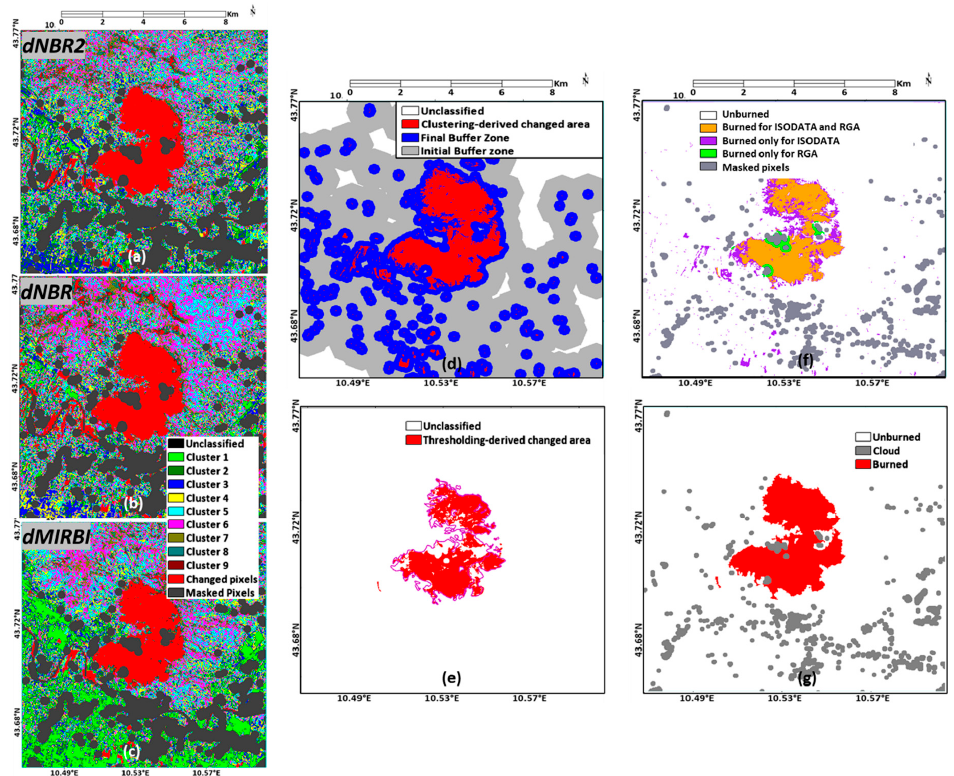
Figure 3. Full example of the results of the BFCA for the EMSR316 test case. Upper left panel ( a ): output of the ISODATA applied to dNBR2 . Central left panel ( b ): output of the ISODATA applied to dNBR . Lower left panel ( c ): output of the ISODATA applied to dMIRBI . Upper central panel ( d ): clustering-derived changed area and buffer zone. Lower central panel ( e ): thresholding-derived changed area. Upper right panel ( f ): pixels belonging to both clustering-derived and thresholding-derived BAs (orange), only to the clustering-derived BA (purple), only to the thresholding-derived BA (green). Lower right panel ( g ): final BA map. All the maps are zoomed on the area affected by the fire. The magenta lines in panel ( e ) represent the boundary of the CEMS-derived burned area.